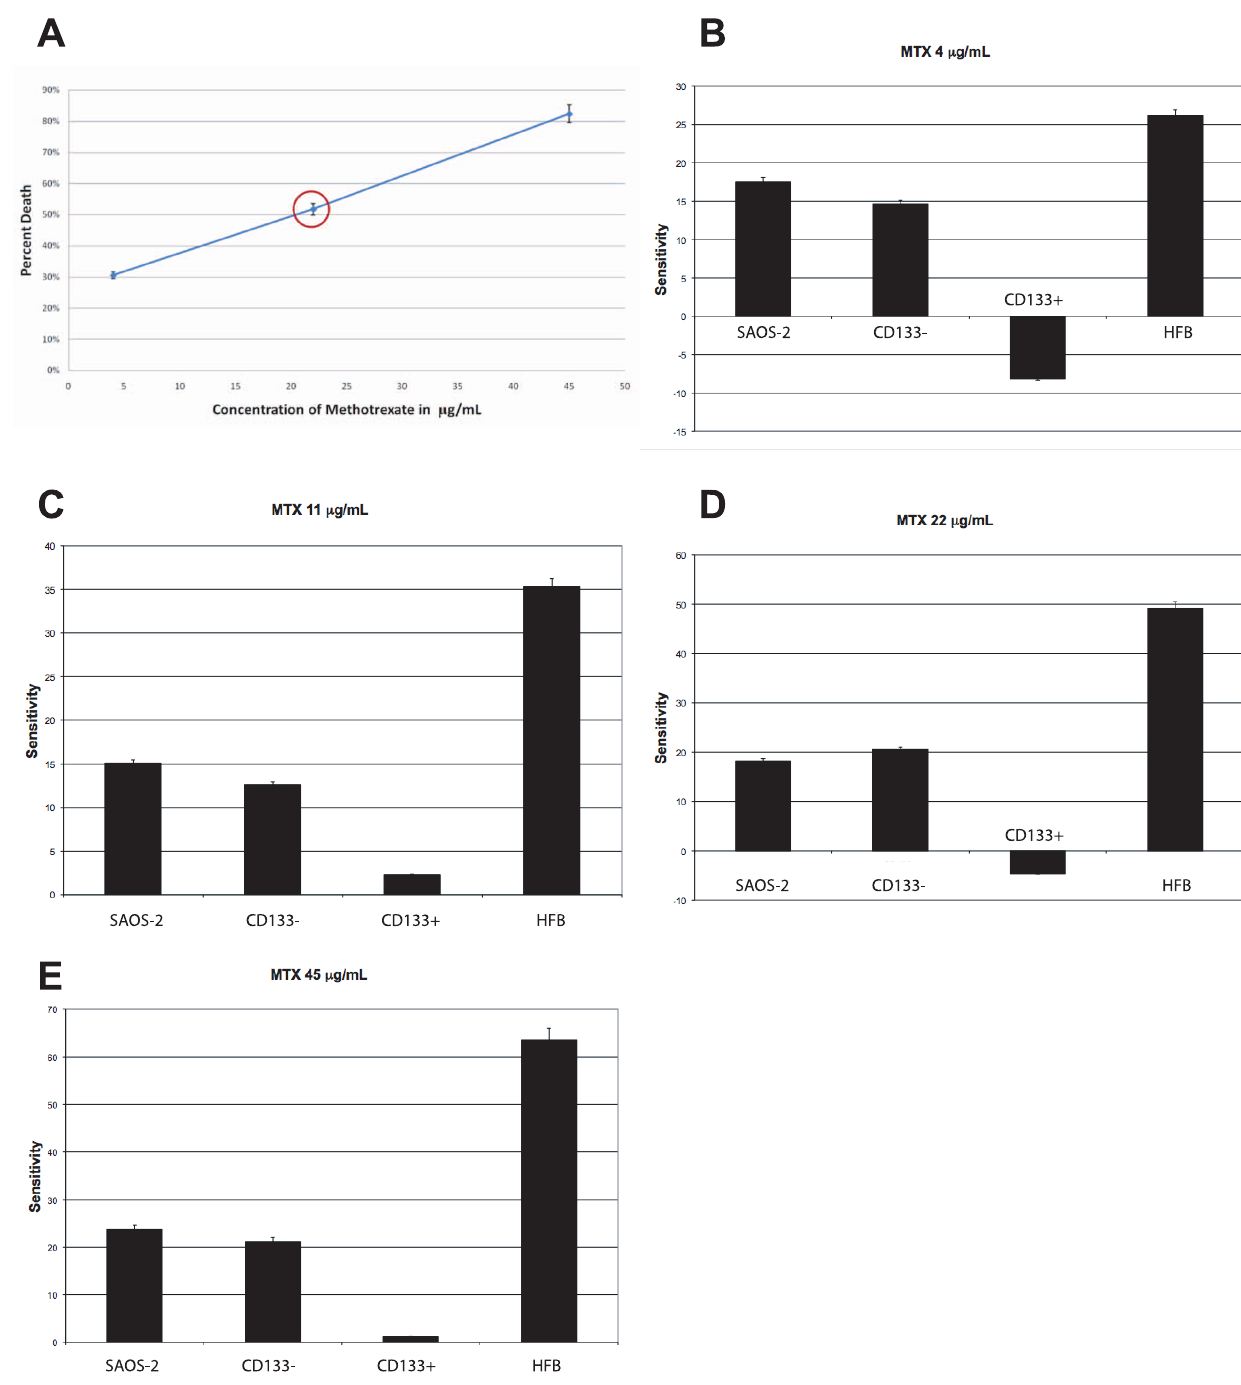
Figure 8. Sensitivity of SAOS-2 cells to methotrexate following growth in simulated hypogravity. A ) LD 50 for methotrexate determined for the SAOS-2 cells. An LD 50 of 22 m g/mL for methotrexate was determined exposing the SAOS-2 cells to a 24-hours treatment to the drug, using the MTT assay. Comparable results were obtained with cell count by trypan blue exclusion. B ) Histogram showing the sensitivity of SAOS-2 cells to 4 m g/mL of methotrexate following a 24-hours treatment, using an MTT assay. CD133( + ) cells are resistant to the chemotherapy treatment, but the CD133( + ) SAOS-2 cells proliferated and selected with the HFB culture system are sensitive, instead. C ) Histogram showing the sensitivity of SAOS-2 cells to 11 m g/mL of methotrexate following a 24-hours treatment, using an MTT assay. CD133( + ) cells are resistant to the chemotherapy treatment, but the CD133( + ) SAOS-2 cells proliferated and selected with the HFB culture system are greatly sensitive, instead. D ) Histogram showing the sensitivity of SAOS-2 cells to a clinically relevant dose of 22 m g/mL of methotrexate following a 24-hours treatment, using an MTT assay. CD133( + ) cells are resistant to the chemotherapy treatment, but the CD133( + ) SAOS-2 cells proliferated and selected with the HFB culture system are sensitive, instead. E ) Histogram showing the sensitivity of SAOS-2 cells to 45 m g/mL of methotrexate following a 24-hours treatment, using an MTT assay. CD133( + ) cells are resistant to the chemotherapy treatment, but the CD133( + ) SAOS-2 cells proliferated and selected with the HFB culture system are sensitive, instead.